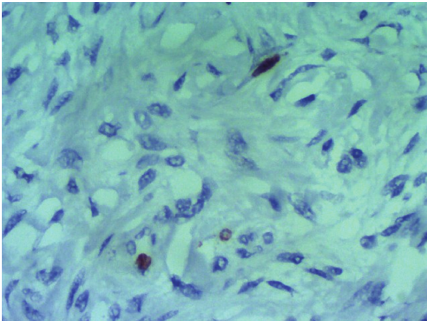
Figure 4: Immunohistochemistry of Ki-67.